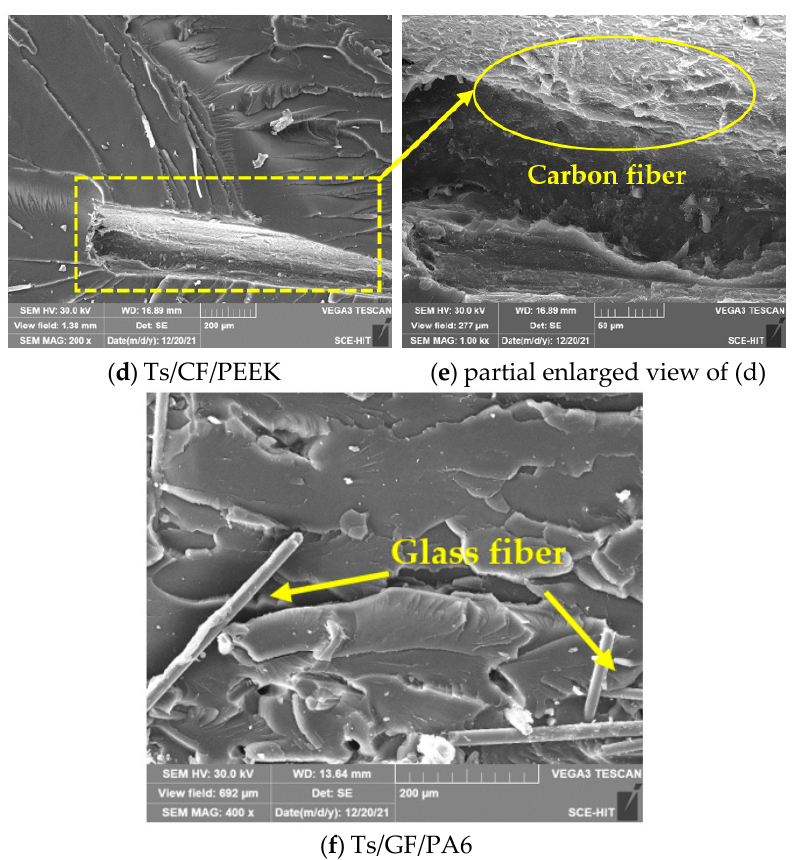
Figure 17. Effects of thermoplastic resin and composite fillers on tensile fracture morphology of Ts resin of ( a ) Ts, ( b ) Ts/CF, ( c ) Ts/GF/PP, ( d ) Ts/CF/PEEK, ( e ) partial enlarged view of ( d ) and ( f ) Ts/GF/PA6.